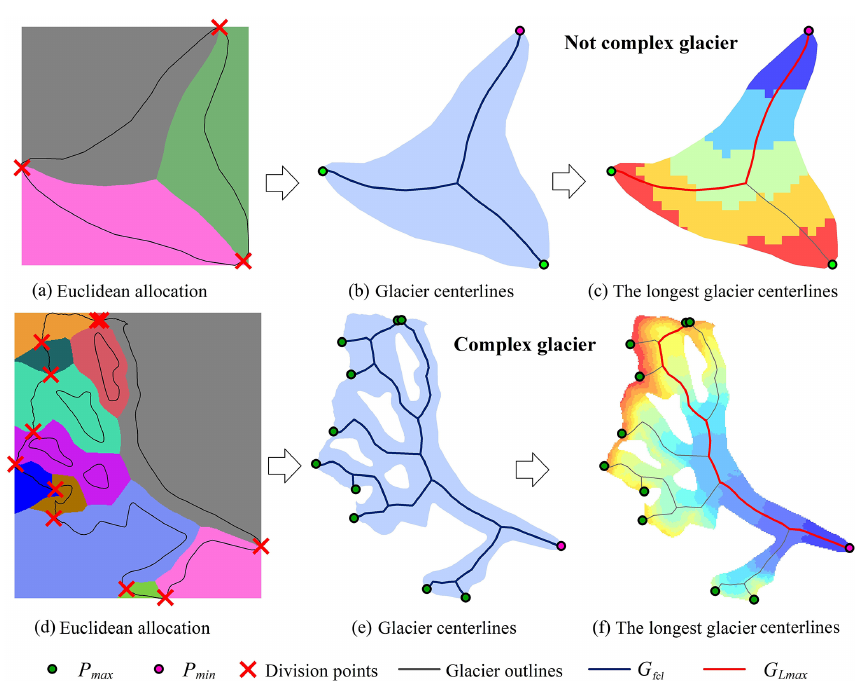
Figure 6. The schematic of extracting centerlines and the longest centerline of the glacier. Panels (a and d) show the results after executing the European allocation, and the different colors represent the regions which have the shortest distance to the corresponding edges of the glacier. Panels (b and e) represent the centerlines( G fcl ), the local highest point ( P max ) and the lowest point ( P min ) of the glacier. Panels (c and f) demonstrate the longest centerline ( G Lmax ) of the glacier, and the background is the digital elevation model with the graduated red (high) – blue (low)